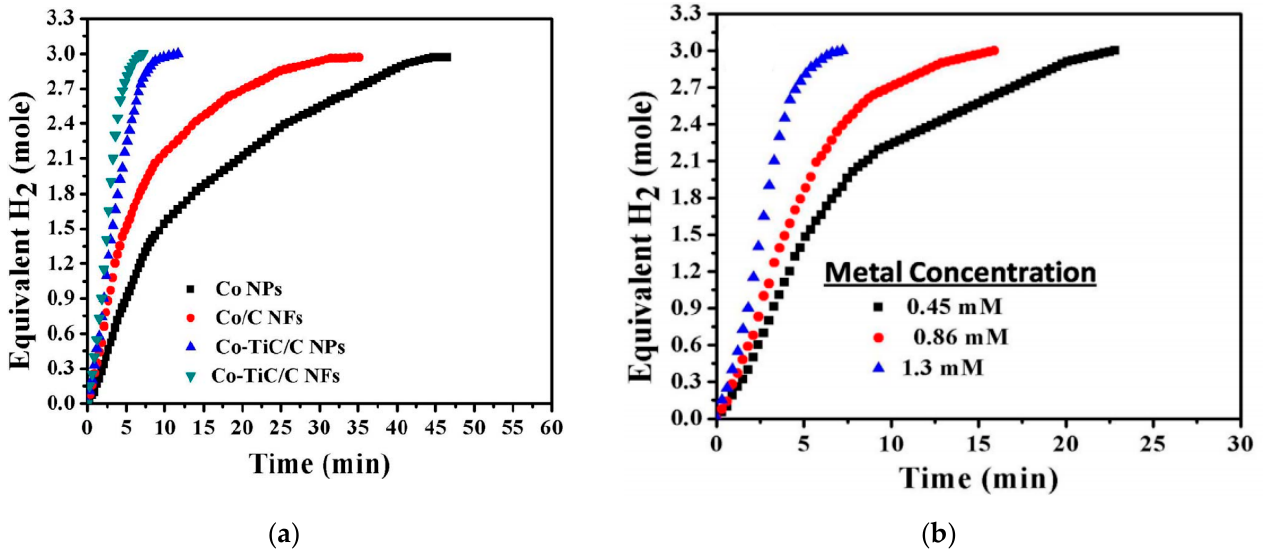
Figure 8. ( a ) Catalytic performance of Co NPs, Co/C NFs, Co-TiC/C NPs, and Co-TiC/C NFs in hydrolysis AB reaction; ( b ) Effect of metal concentration on H 2 generation. Reprinted from reference [96] with permission from Elsevier.